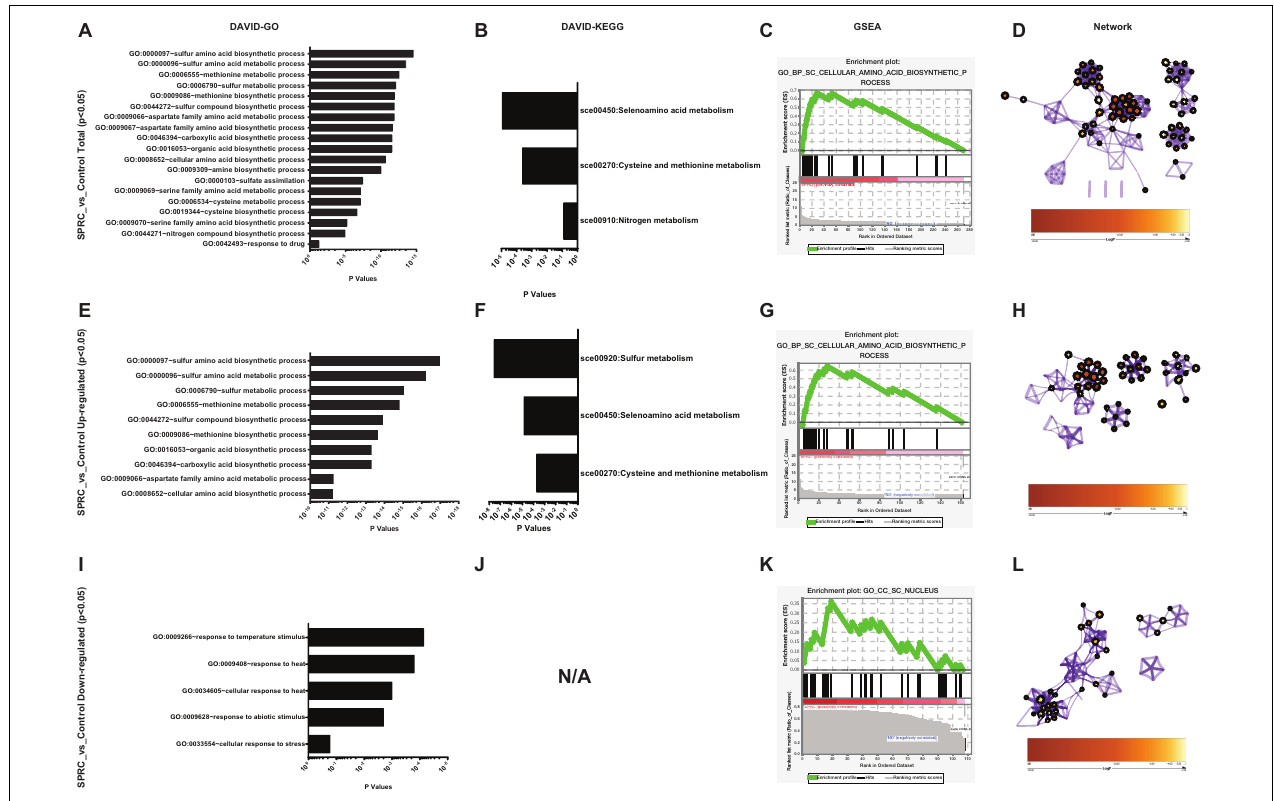
FIGURE 3 | S -propargyl-cysteine (SPRC) elevating the expression of the genes involved in sulfur-amino-acid biosynthesis. (A) DAVID-GO analysis result of the total SPRC-significantly-influenced genes highlights the “GO:0000097” term of “sulfur amino acid biosynthetic process.” The horizontal axis shows the p -values of each enriched GO terms. (B) DAVID-KEGG analysis result of the total SPRC-significantly-influenced genes highlights the “sce00450” pathway of “Selenoamino acid metabolism.” The horizontal axis shows the p -values of each KEGG pathway. (C) The GSEA result showed the total SPRC-significantly-influenced genes are enriched into the Top-1-ranked GO term of “cellular amino acid biosynthetic process” with the enrichment score of 0.669408 and the nominal p -value of 0.00101833. (D) In Metascape-generated GO network, the total SPRC-significantly-influenced genes are mainly enriched in the GO terms related to sulfur-amino-acid biosynthetic process with a relatively small logP-value ( Table 1 ). (E) DAVID-GO analysis result of the SPRC-upregulated genes. (F) DAVID-KEGG analysis result of the SPRC-upregulated genes. (G) The GSEA result showed the SPRC-upregulated genes. (H) In Metascape-generated GO network, the SPRC-upregulated are mainly enriched in the GO terms related to sulfur-amino-acid biosynthetic process with a small logP-value ( Table 2 ). (I) DAVID-GO analysis result of the SPRC-downregulated genes. (J) DAVID-KEGG analysis result of the SPRC-downregulated genes fail to be enriched in any KEGG pathway even when the “classification stringency” is set to “lowest,” which implies that the SPRC-downregulated genes are not pathway-directed. (K) The GSEA result showed the SPRC-downregulated genes. (L) In Metascape-generated GO network, the SPRC-downregulated are mainly enriched in the GO terms related to energy and oxidation processes with a relatively large logP-values ( Table 3